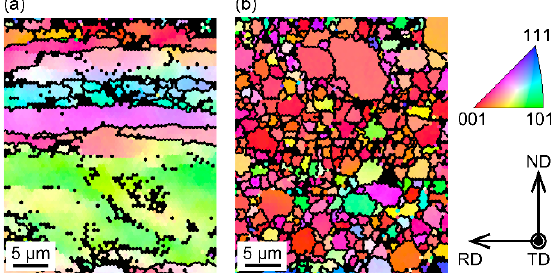
Figure 9. IPF maps of the rolled specimens after heat treatment at 500 °C for ( a ) 1 min and for ( b ) 5 min.